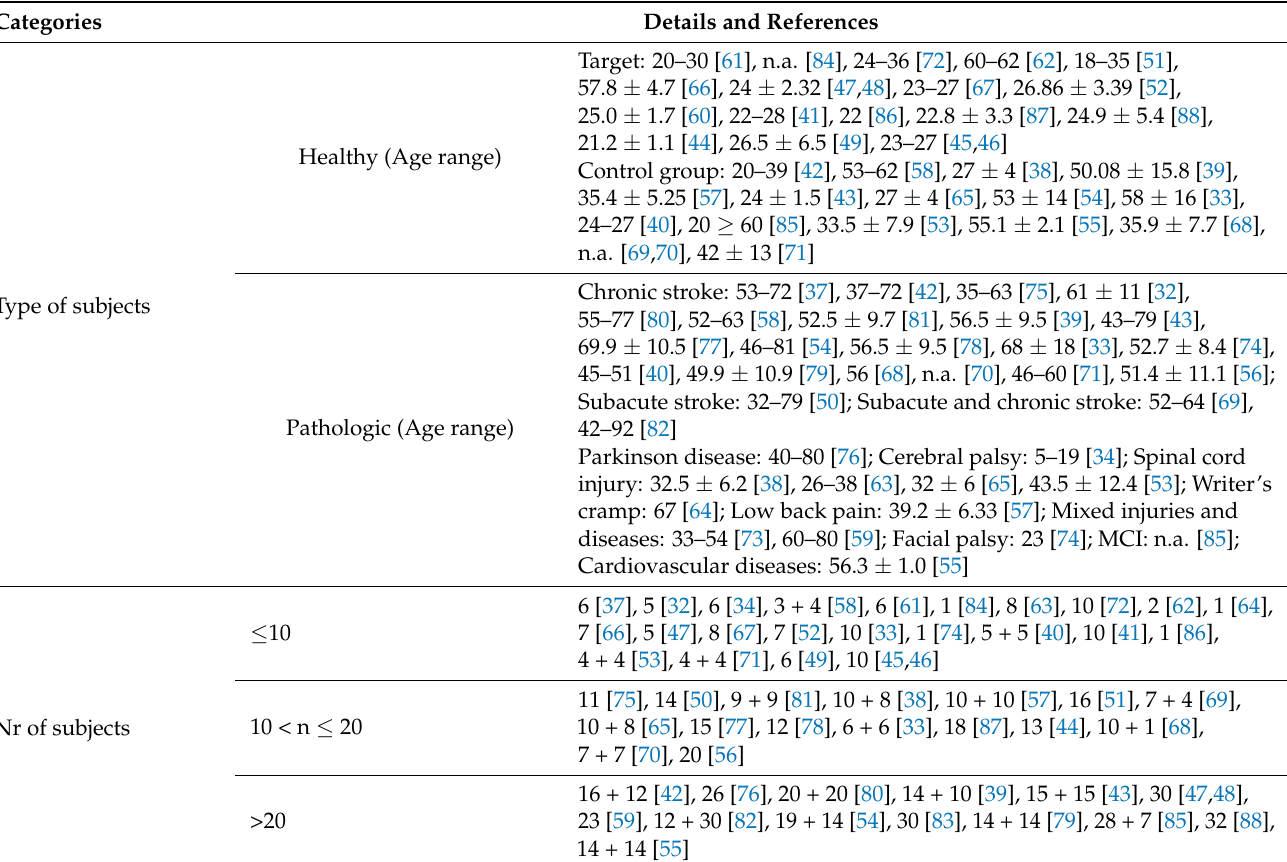
Table 2. Subjects and anatomical